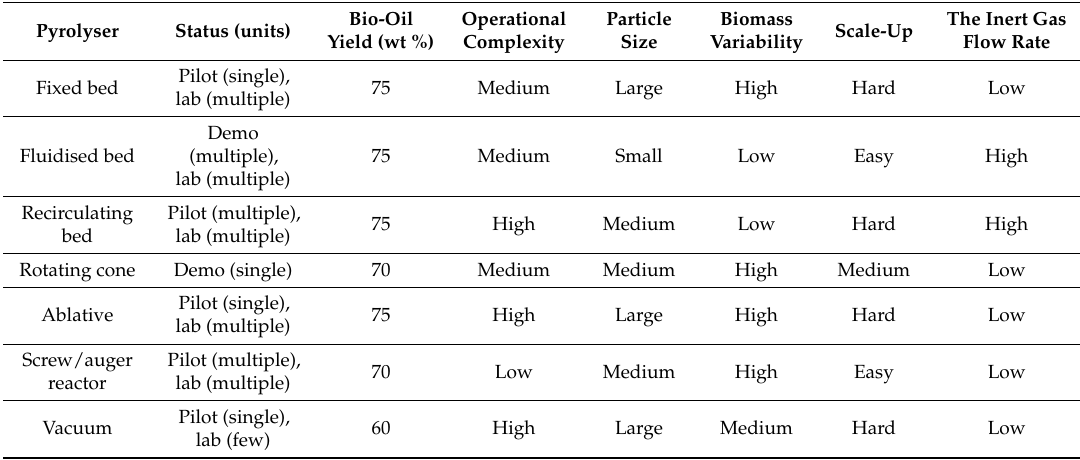
Table 5. Comparison of various biomass pyrolysis reactors based on overall performance and efficiency [96].